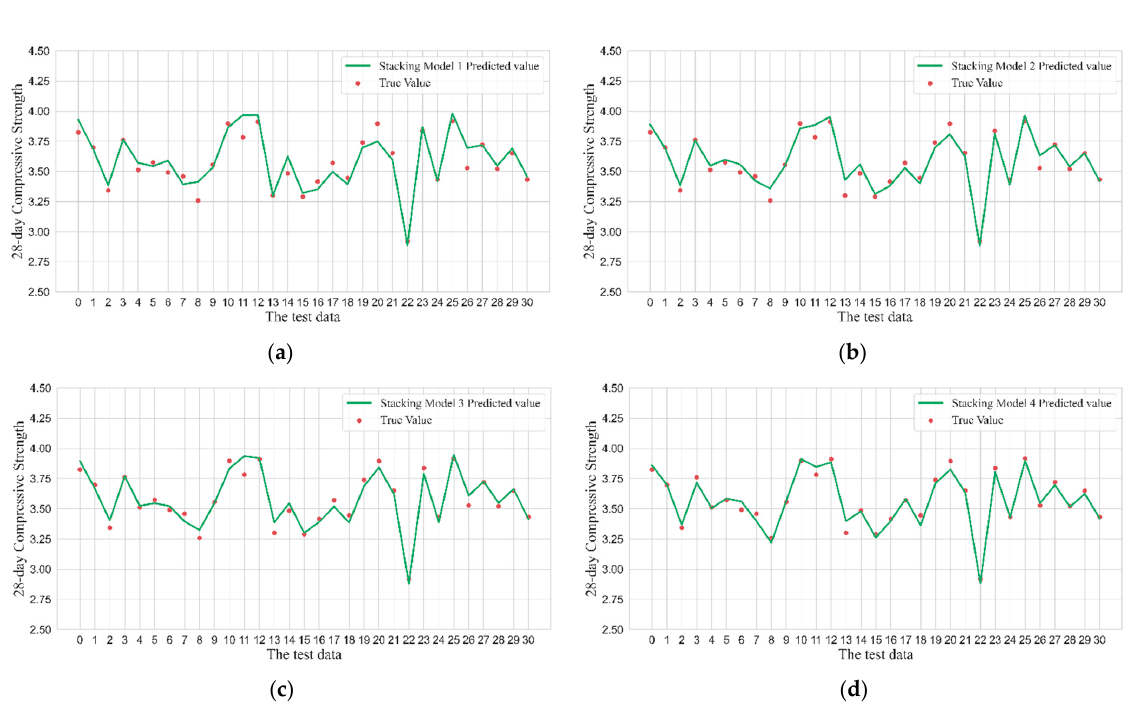
Figure 11. Comparison of prediction errors of different stacking models: ( a ) Stacking model 1 builds